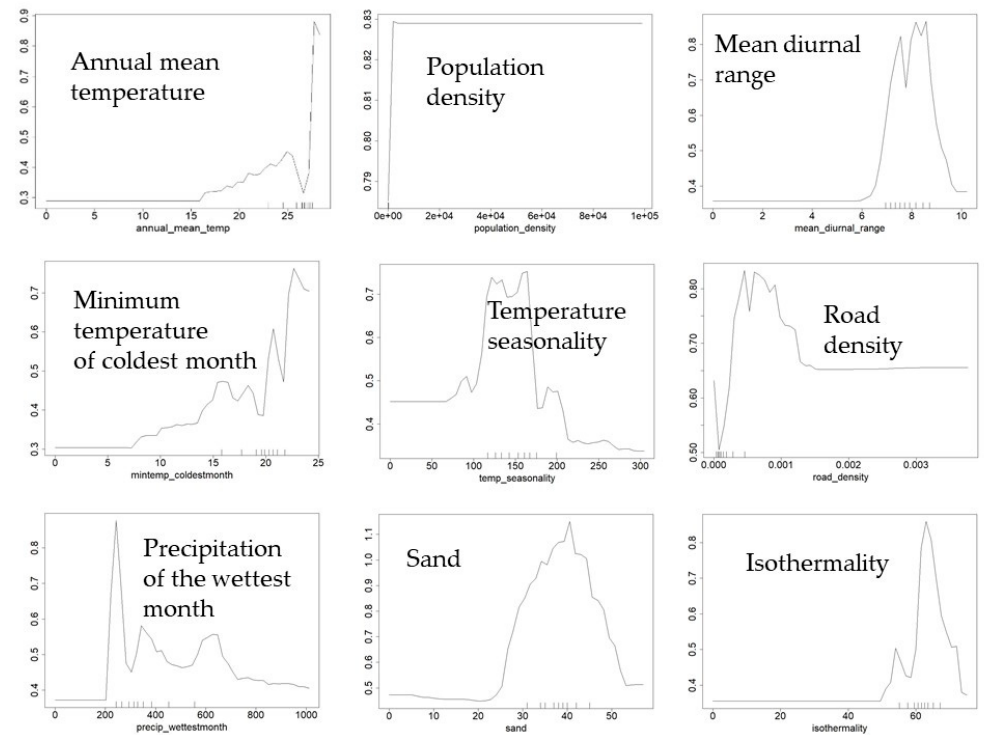
Figure A3. Top nine predictor variables for the Cambodia + 3S model make up 47% of the variable contribution. Note the small vertical lines on the x axis (rug) that indicate where the majority of the data points are located.